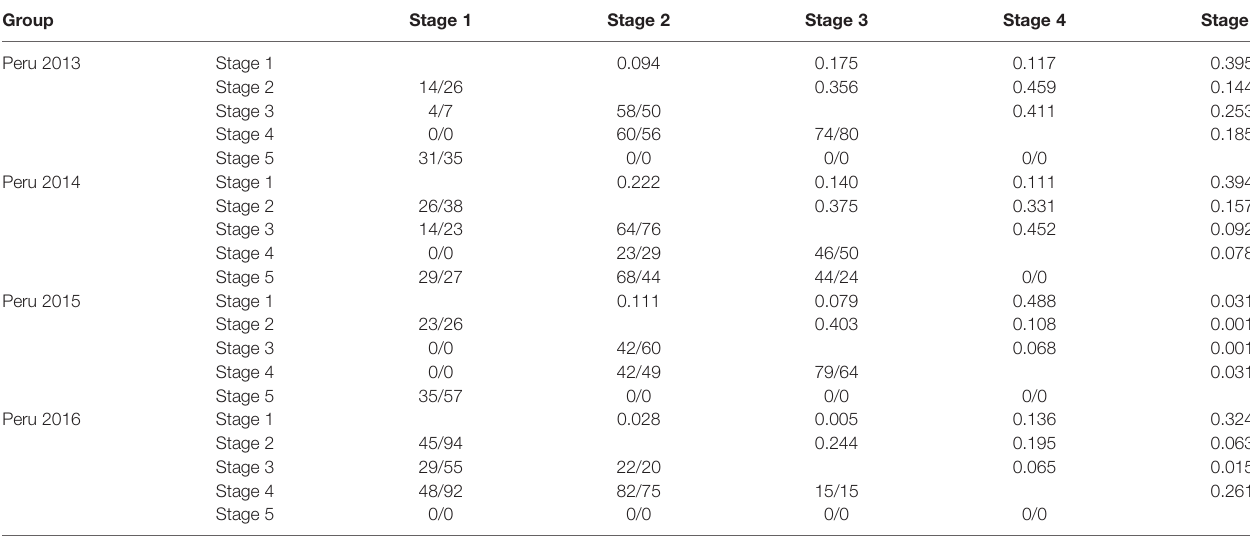
TABLE 5 | Ontogenetic variation in isotopic niche of males for different groups.